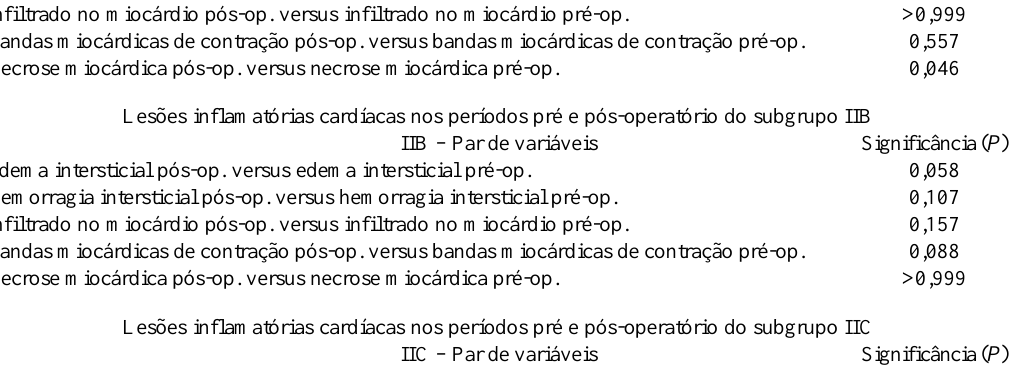
Edema intersticial pós-op. versus edema intersticial